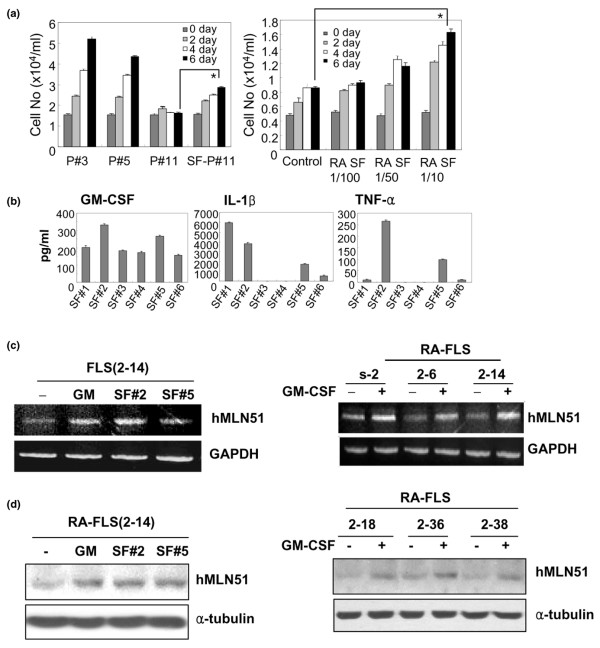
The growth kinetics of RA FLSs at different passages or in SF-treated cultures. (a) Rheumatoid arthritis (RA) fibroblast-like synoviocytes (FLSs) at passages 3 (P#3), 5 (P#5) and 11 (P#11) were used to measure their growth kinetics. RA FLSs (2–14) at passage 11 was treated with diluted synovial fluid (SF) no. 2 (1/100, 1/50 or 1/10 dilutions) to evaluate growth recovery; the culture was incubated for 6 days and the concentrations of treated SF were as follows: left panel, 1/10 dilution; right panel, 1/100, 1/50 and 1/10 dilutions of SF. *p < 0.01. (b) The concentration of granulocyte – macrophage colony-stimulating factor (GM-CSF) and cytokines in SFs from each patient with RA. Six SF samples were analyzed for their concentrations of GM-CSF and other cytokines with an ELISA kit and a Cytometric Bead Array kit. The results in (a) and (b) are means ± SD obtained from single experiments performed in triplicate cultures. (c, d) MLN51 expression was quantified by RT-PCR (c) and Western blot analysis (d) in SF-treated or GM-CSF-treated RA FLSs. The high-passage-number RA FLSs (RA 2–14, passage 11) were treated with GM-CSF (100 ng/ml) or 1/10-diluted SF every 2 days for 6 days (left panels). In addition, the expression of MLN51 was evaluated in six different RA FLS samples treated with or without GM-CSF (100 ng/ml; right panels). See the Materials and methods section for a detailed description. Data in (c) and (d) are representative of three separate experiments.